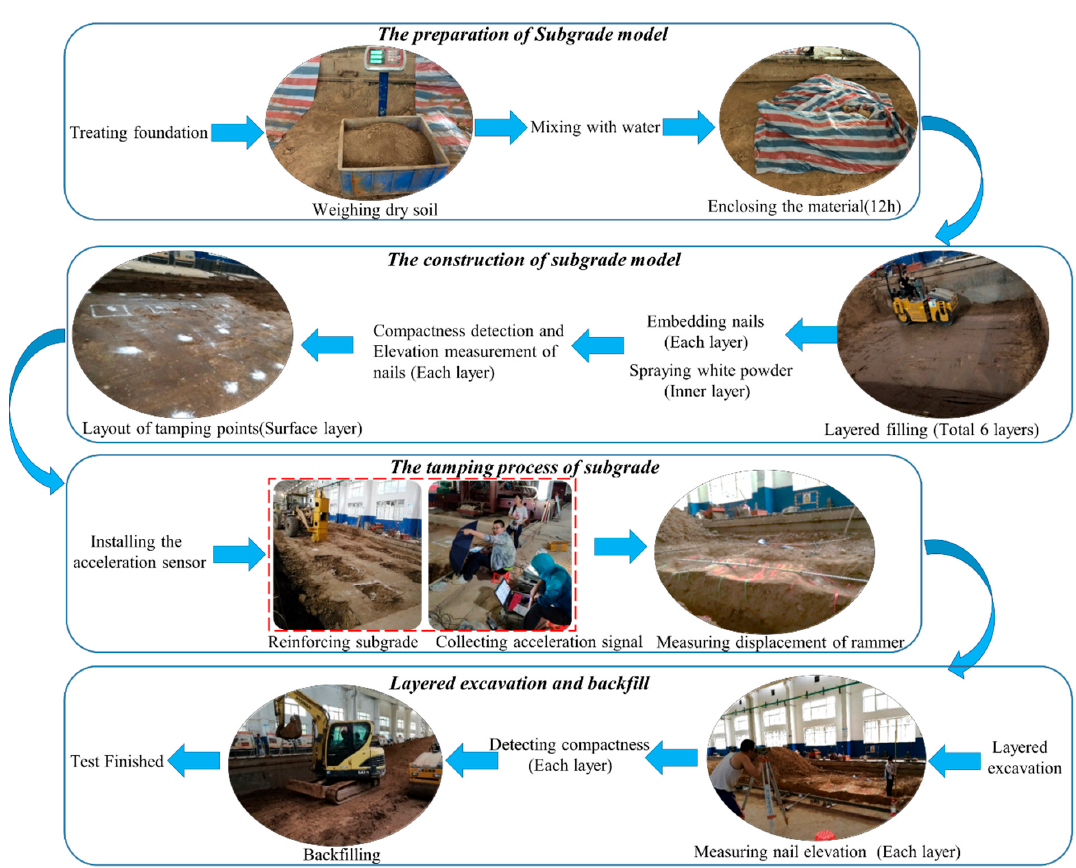
Figure 6. Process of hydraulic compactor testing for reinforcing loess subgrade.